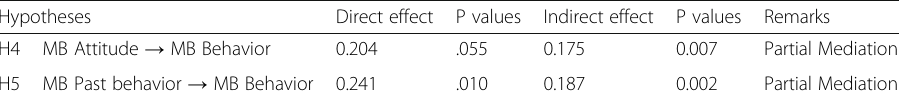
Table 6 Mediation analysis